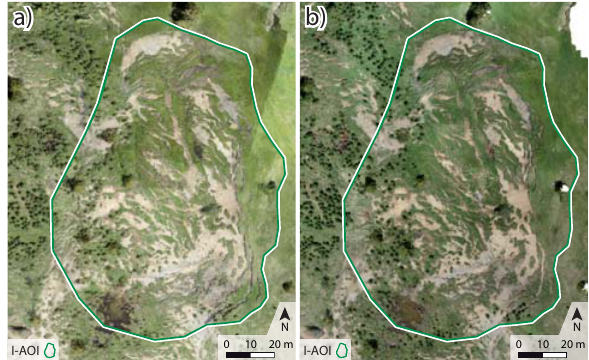
Figure 8. Proportions of the sensors’ points in the integrated point clouds for 2016 (a-d) and 2017 (e-h) resulting from the Figure 7. RGB orthophotos based on the UAV data of 2016 (a) applied integration rules ’maximum geometric curvature’ (a, e), and 2017 (b). ’maximum planarity’ (b, f), ’minimum elevation’ (c, g) and ’sensor correspondence’ (d, h). Results are shown for different voxel dimensions ( s v = 0 . 1 , 0 . 2 , 0 . 5 , 1 . 0 m). tion because of their area-wide coverage, partly without overlap- ping data of the other sensors. Figure 9 (data of 2016) and 10 (data of 2017) show the spatial dis- tribution of the decisions on which sensor’s points to keep in the voxels of size 0.2m for the four applied integration rules. In case of the ’maximum geometric curvature’ rule (Fig. 9a, Fig. 10a), the TLS points are preferred over UAV data on convex land- forms. Generally, TerrPh points are preferred over the other sensors within its smaller acquisition area (See Fig. 5). Con- sidering the ’maximum planarity’ rule, mainly